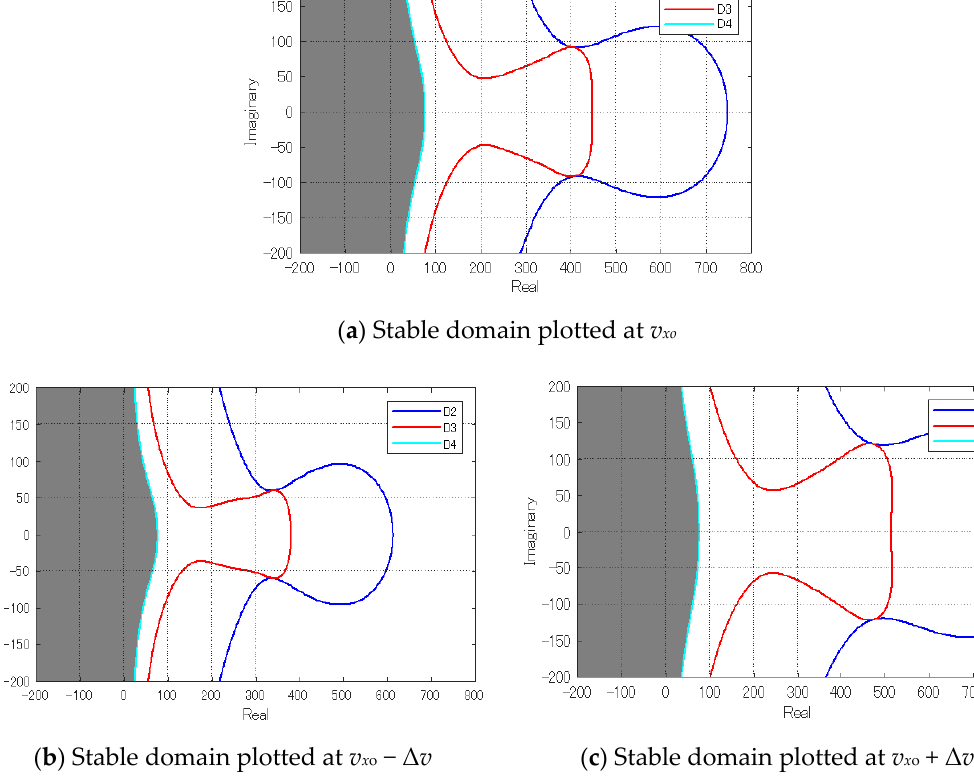
Figure 18. Stable domain given by the generalized frequency variable (GFV) (shaded region). Notice: the curve D 1 ( x , y ) = 0 is a vertical line. It is not plotted since it exceeds the range of the figures.